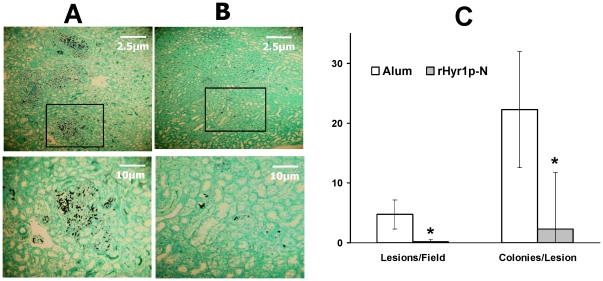
Representative histopathological sections from kidneys were shown.(A) Control mice infected with C. albicans had multiple abscesses showing mostly yeast forms with some hyphae and pseudohyphae throughout the kidneys. (B) rHyr1p-N vaccinated mice (33 µg) infected with C. albicans had less abscesses with far less fungi visible. (C) Semiquantitative evaluation of the severity of infection indicated significant abscess and Candida cells reduction in vaccinated mice compared to control mice. Sections were stained by PAS. Thirty random fields were examined by a blinded assessor (GL) to assess the number of lesions per field. Number of organisms per lesion was evaluated in 120 lesions in the control unvaccinated mice. The average number of organisms per lesion was determined by dividing the total number of fungal cells by the number of lesions counted. * P<0.0001 by Wilcoxon rank sum test.